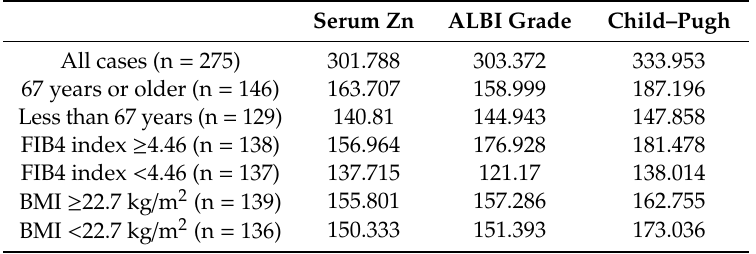
Table 2. Akaike information criterion value in each prognostic model. Serum Zn ALBI Grade Child–Pugh